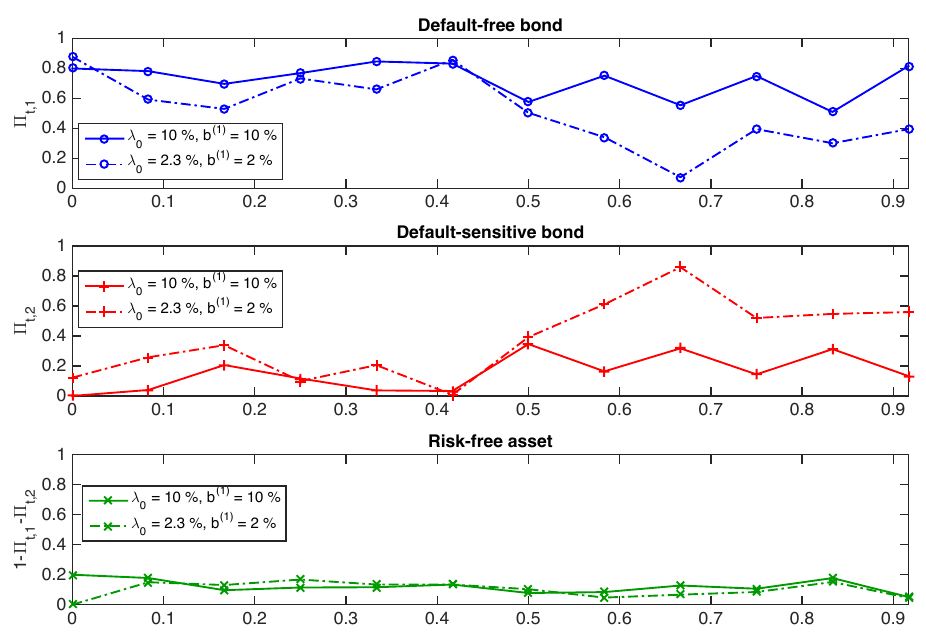
Figure 5. Sensitivity of optimal strategies to a change in the level of default